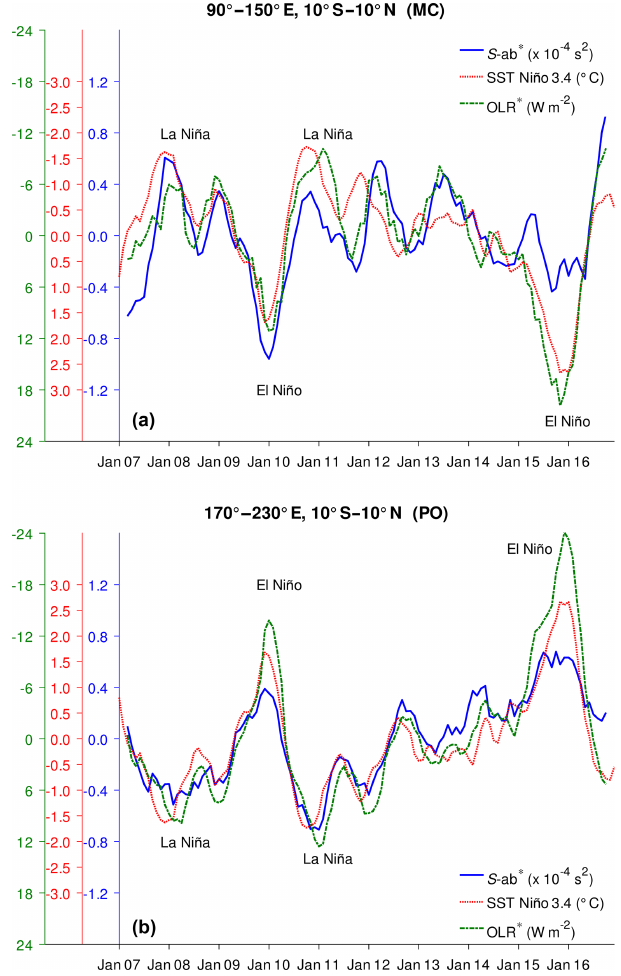
Figure 10. Interannual variations in a S -ab anomaly ( S -ab ∗ ) (solid blue line), OLR anomaly (OLR ∗ ) (dashed-dotted green line), and SST Niño 3.4 index (dotted red line) for the MC (a) and PO (b) . Note that the ordinate axes of both OLR ∗ and SST Niño 3.4 index are reversed in panel (a) , but only the ordinate axis of OLR ∗ is reversed in panel (b) .